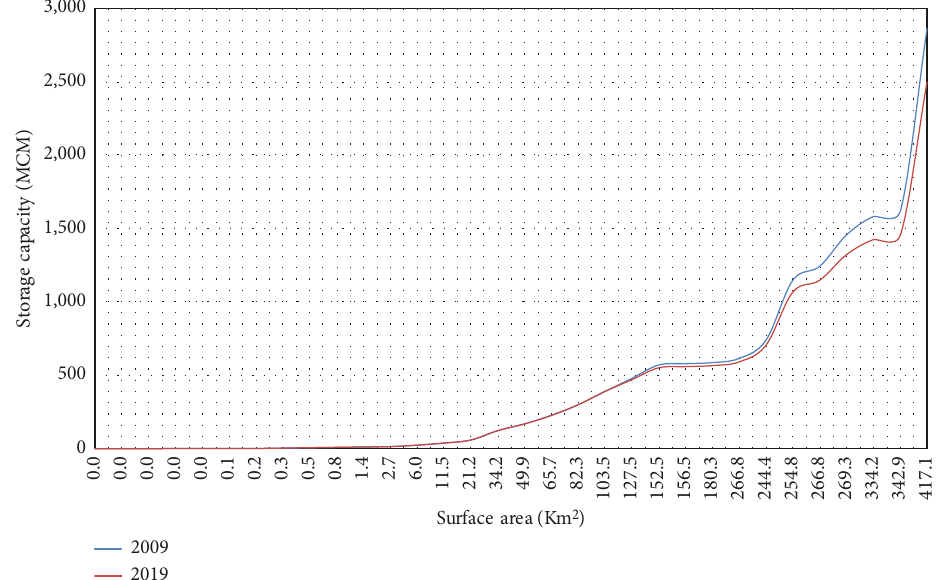
Figure 6: The storage capacity-surface area relationship of the Ubolratana reservoir in 2009 and in